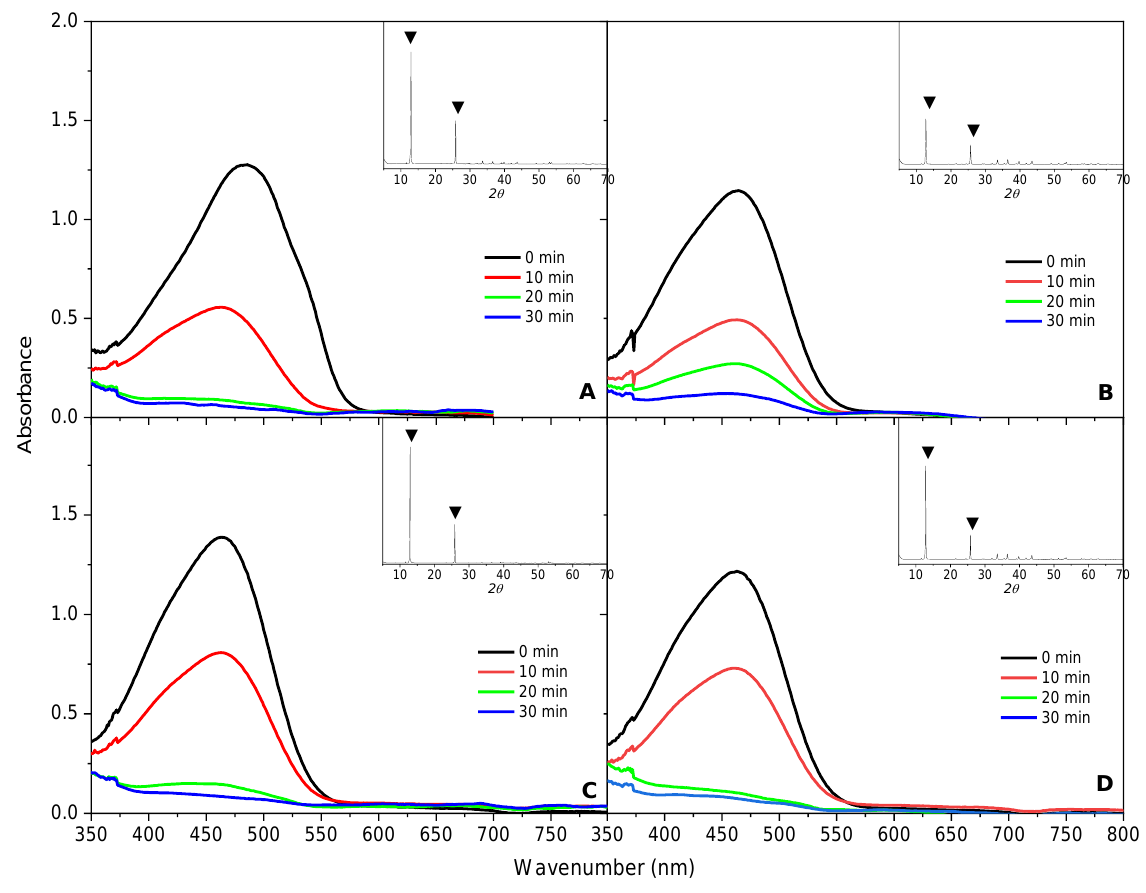
Figure 5. UV-Vis spectra of methyl orange photocatalysis using the Cu 2 (OH) 3 NO 3 as catalyst. The reaction conditions were: ( A ) pH 3 and temperature 25 ◦ C, ( B ) pH 9 and temperature 25 ◦ C, ( C ) pH 3 and temperature 50 ◦ C, and ( D ) pH 9 and temperature 50 ◦ C. The insets represent the X-ray diffraction pattern for each catalyst after reaction.